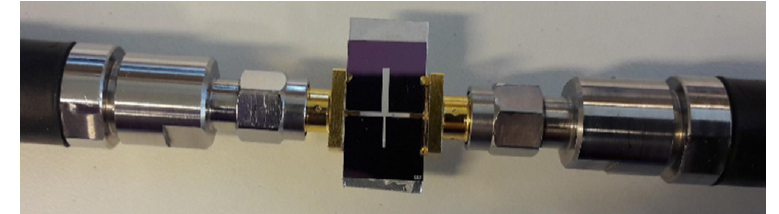
Figure 6. Photograph of switchable DBR 1 .